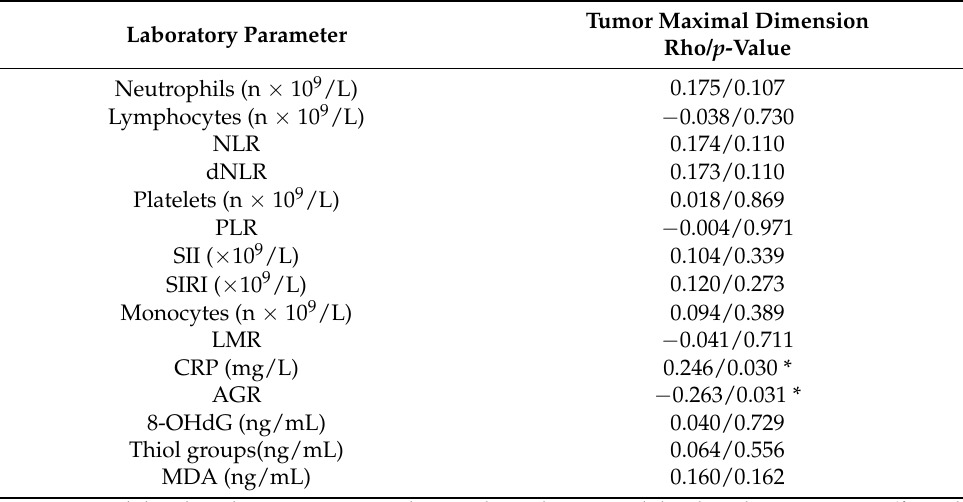
(Table 5). A significant association was observed for CRP and AGR (CRP vs. tumor maxi- mal dimension rho = 0.246, p = 0.030 and AGR vs. tumor maximal dimension rho = − 0.263, p = 0.031). Table 5. Correlation of preoperative inflammatory and redox biomarkers with tumor maximal dimension in testicular GCT